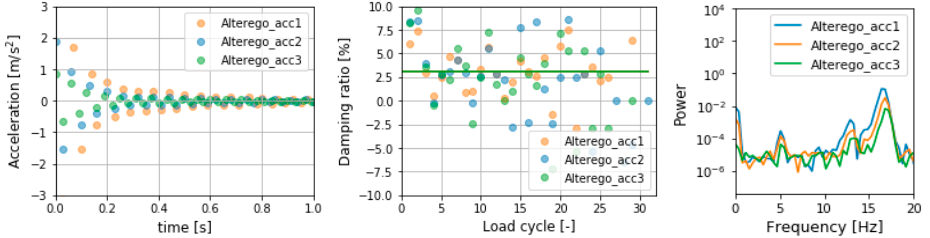
Figure 7. Results relative to tail decay test for the Alterego Board. ( left ) comparison of decay tests; ( center ) Damping ratio in each cycle; ( right ) Power Spectral Density and natural